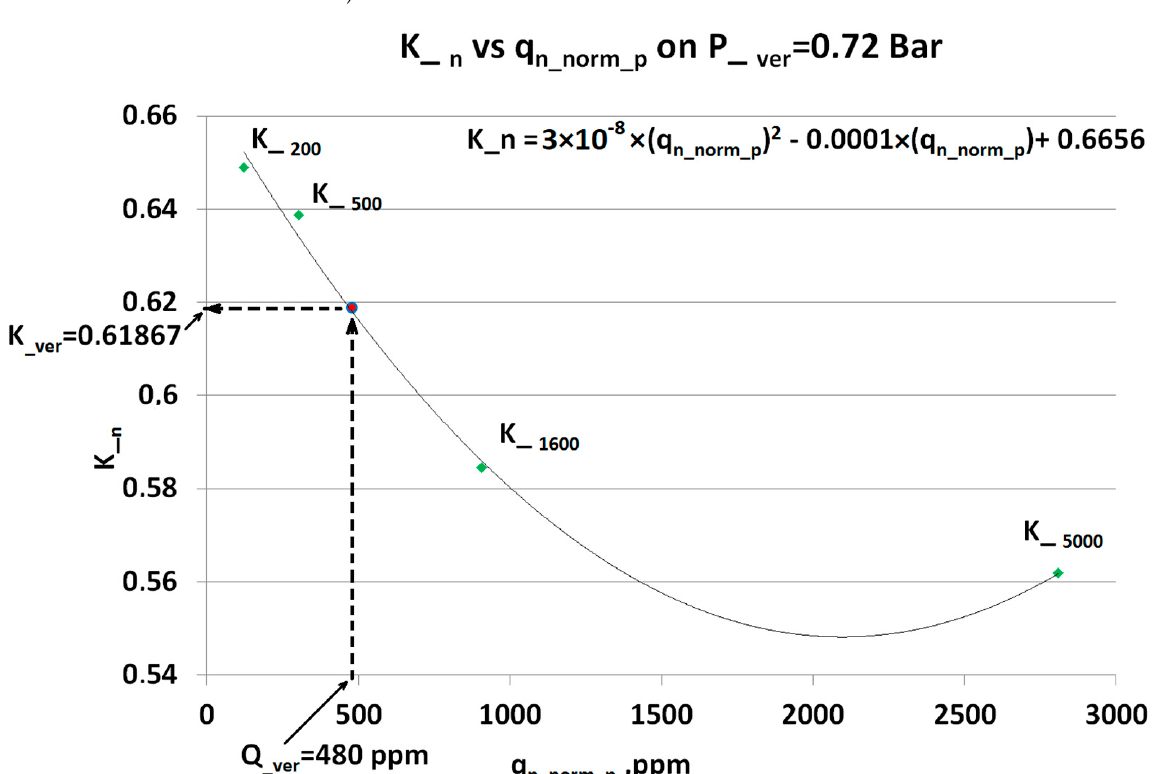
Figure 10. The dependence K _n vs. q n_norm_p contains a set of all possible compensation factors within calibrated range at the specific pressure (here P _ver = 0.72 Bar) where q meas was obtained. The K _n dependence equation gives the value of the compensation (here K _ver ) matching the respective reported q meas (here Q _ver ).